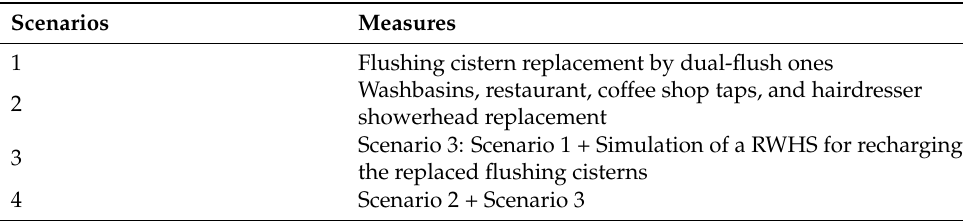
Table 2. Proposed water saving scenarios in the Bragança municipal